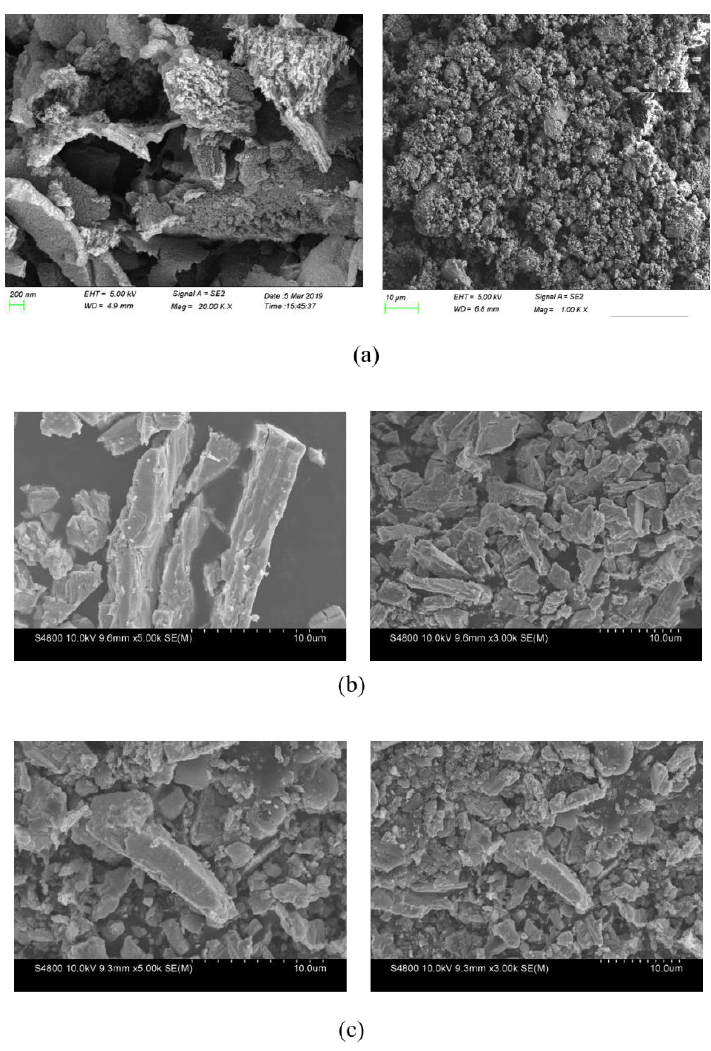
Figure 9. SEM images of ( a ) g-C 3 N 4 , ( b ) CeO 2 and ( c ) g-C 3 N 4 / CeO 2